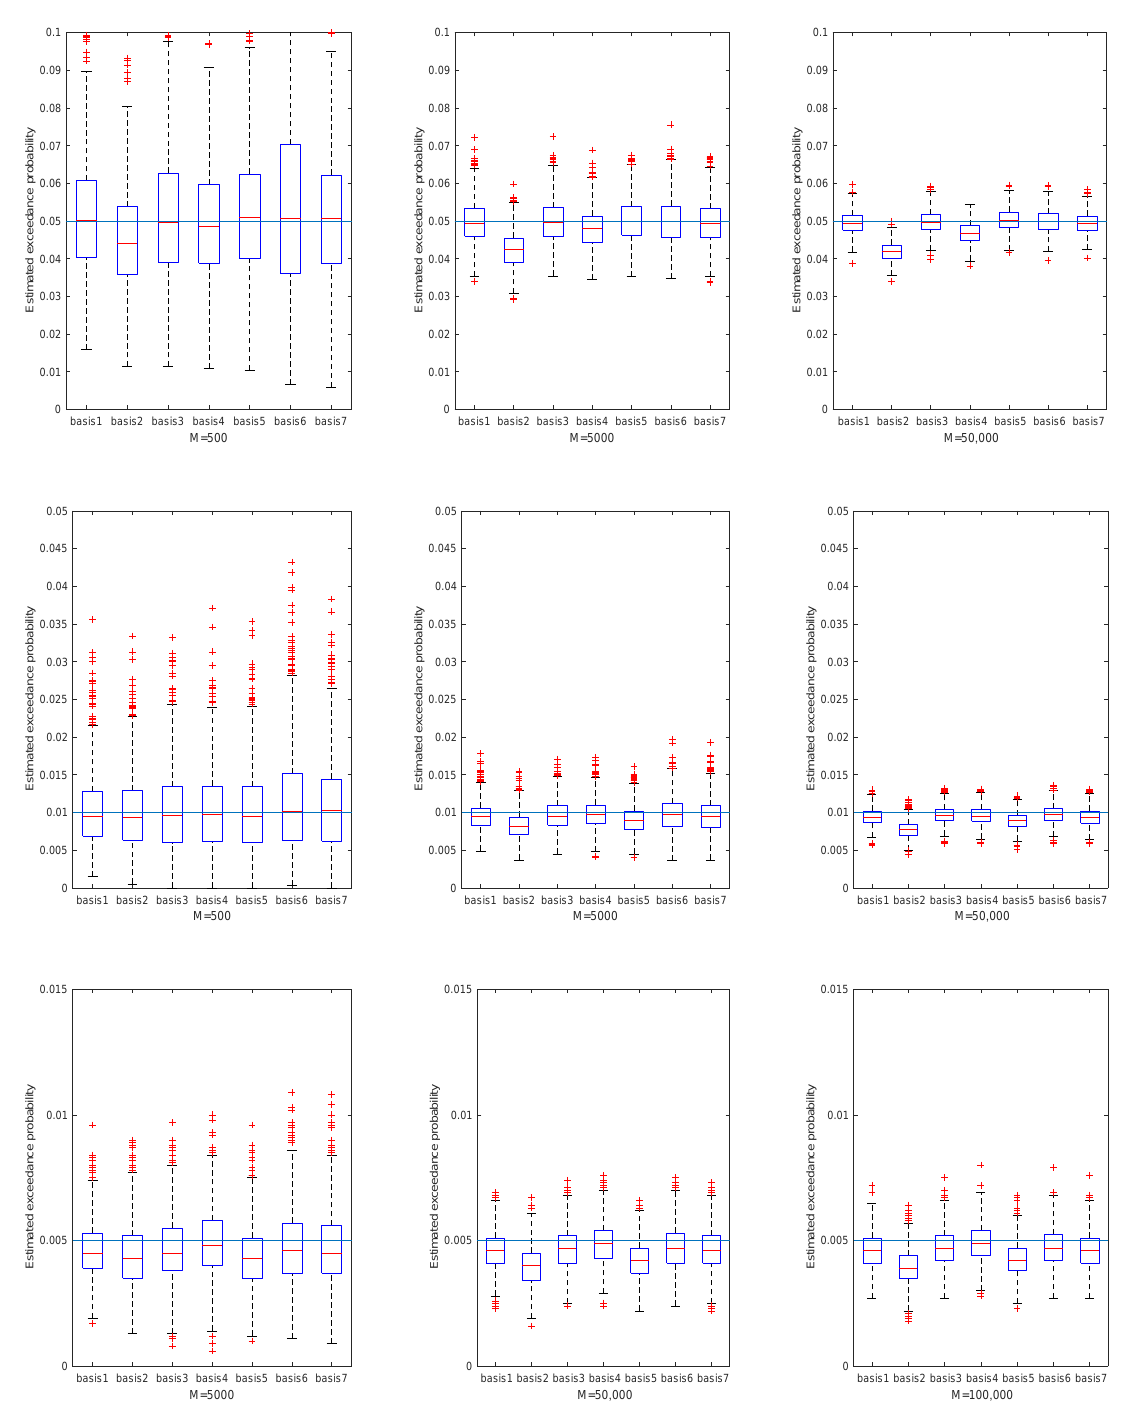
Figure 2. The estimated exceedance probability given the estimated VaR in portfolio 1. Set α = 0.95, 0.99 and 0.995. The three subfigures in the first row correspond to α = 0.95, the three subfigures in the second row correspond to α = 0.99, and the three subfigures in the third row correspond to α =